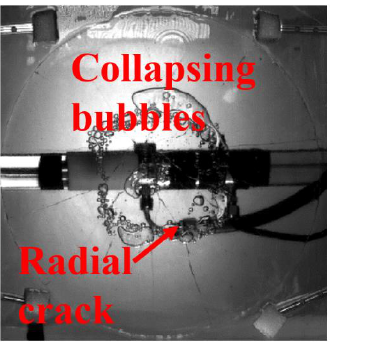
Figure 11. Radial cracks pattern when H = 1.49, T = 0.28.